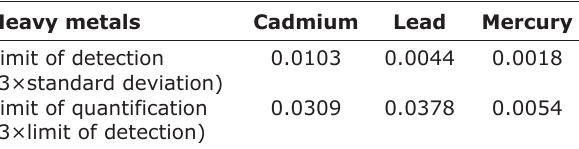
Table-1: Limits of detection and quantification of mercury, cadmium, and lead (mg/kg). Heavy metals